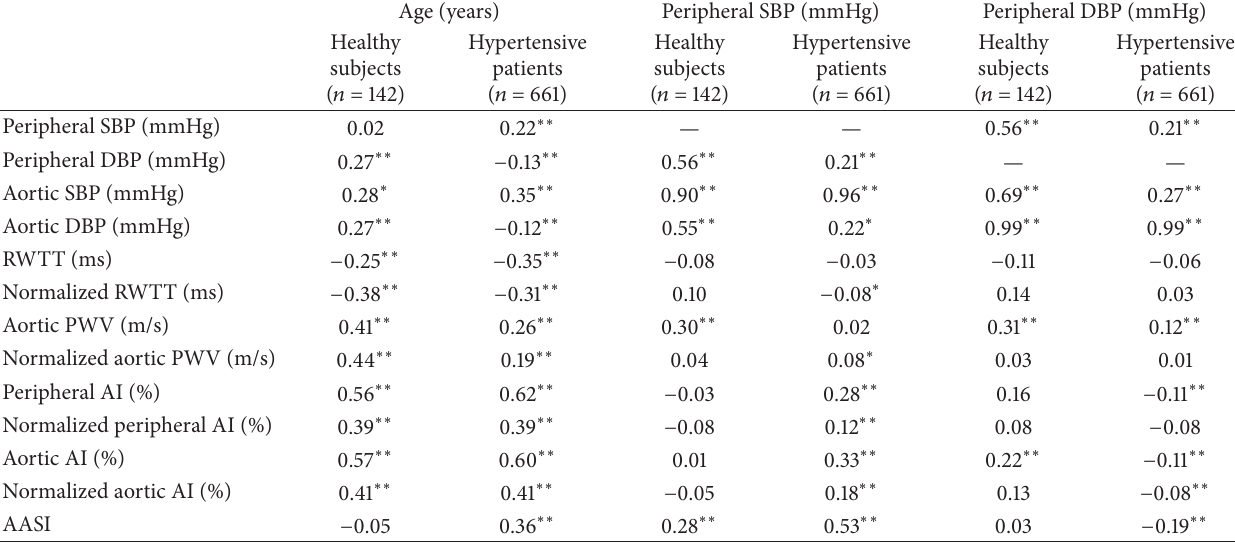
Table 3: Correlation coefficients of 24-hour BP and arterial stiffness measures with age and peripheral (brachial) SBP and DBP.